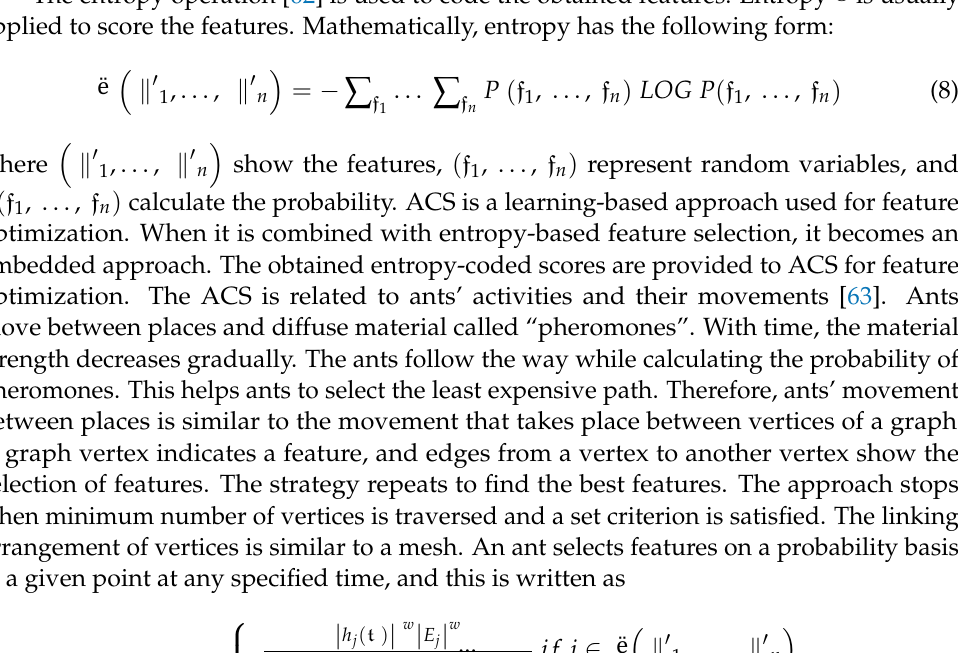
Figure 3. 4-BSMAB best activation visualizations of an image at various convolutional layers: ( a ) original image; ( b ) C1_1; ( c ) C2_1; ( d ) C2_2; ( e ) C3_1; ( f ) C3_2; ( g ) C4_2; ( h ) C7_1.